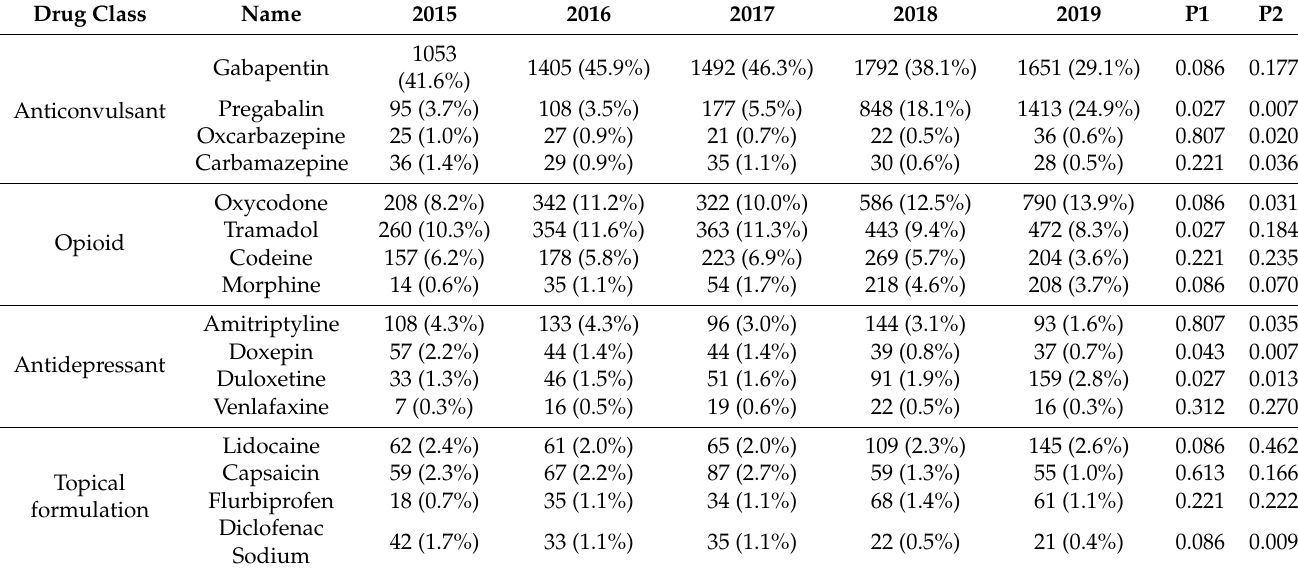
Table 2. Number of yearly prescriptions for specific drugs from 2015 to